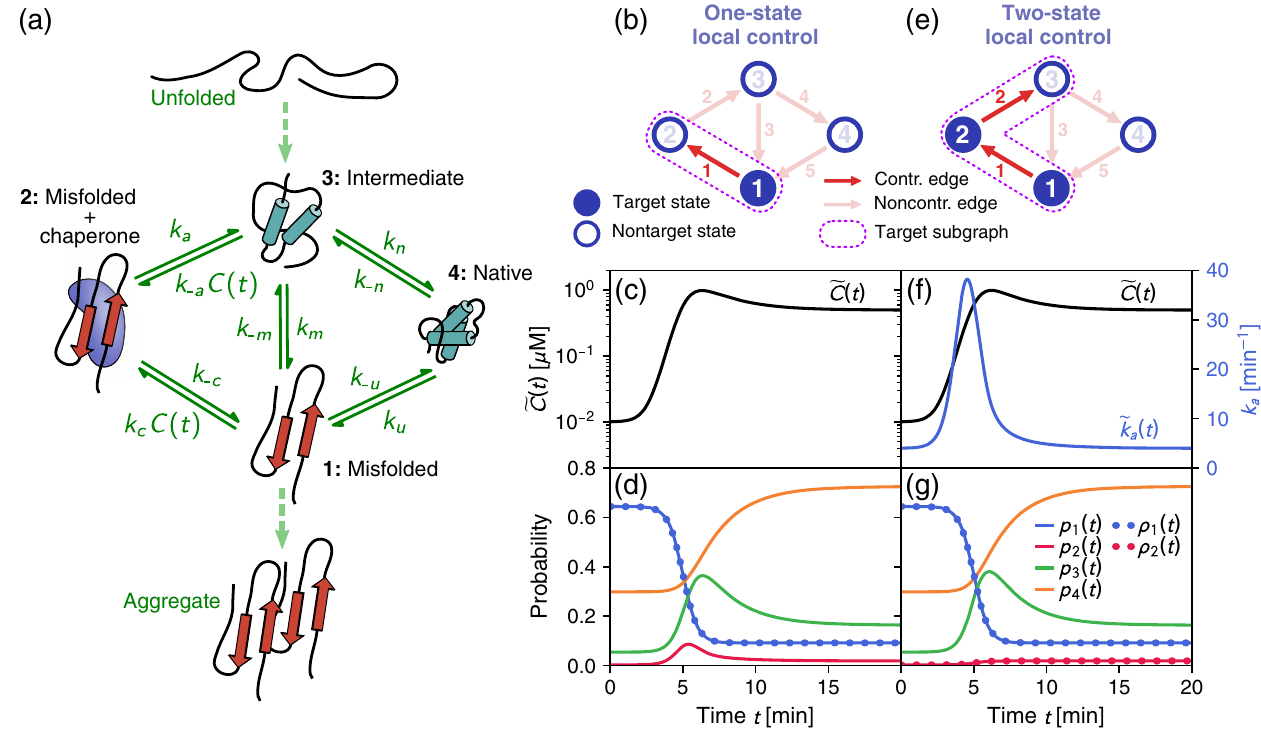
FIG. 8. (a) Conformational states of a protein interacting with a chaperone. Transition rates in our kinetic network model are indicated by solid green arrows. Related transitions outside the scope of the model are shown as dashed arrows. (b) If k a is fixed and k − a C ð t Þ is negligible, there is effectively only one controllable edge in the network, the one between state 1 and state 2. We can thus choose a target subgraph to enable one-state local control, with state 1 (misfolded) as our target. (c),(d) Example of a one-state local control solution, ˜ C with a chaperone concentration protocol ð t Þ in (c) forcing the state 1 probability p 1 ð t Þ to follow a target sigmoidal decrease in the misfolded probability ρ 1 ð t Þ in (d). The state probabilities p i ð t Þ , i ¼ 1 ; … ; 4 , are calculated by numerical solution of the master equation, with parameters described in Appendix C. (e) – (g) Same as (b) – (d) except with an additional controllable edge due to varying ATP levels, allowing k a ð t Þ to be time dependent. We can now have two-state local control, targeting states 1 and 2, and find a protocol of